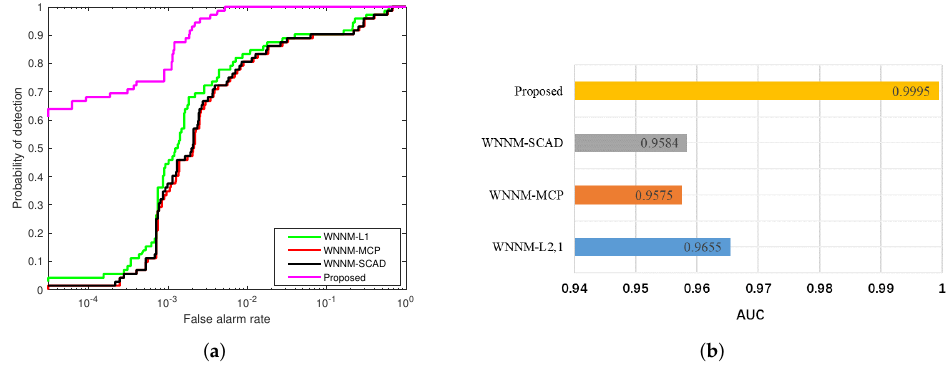
Figure 14. Visualizing ROC curves and AUC values in the SpecTIR dataset. ( a ) ROC curves. ( b ) AUC